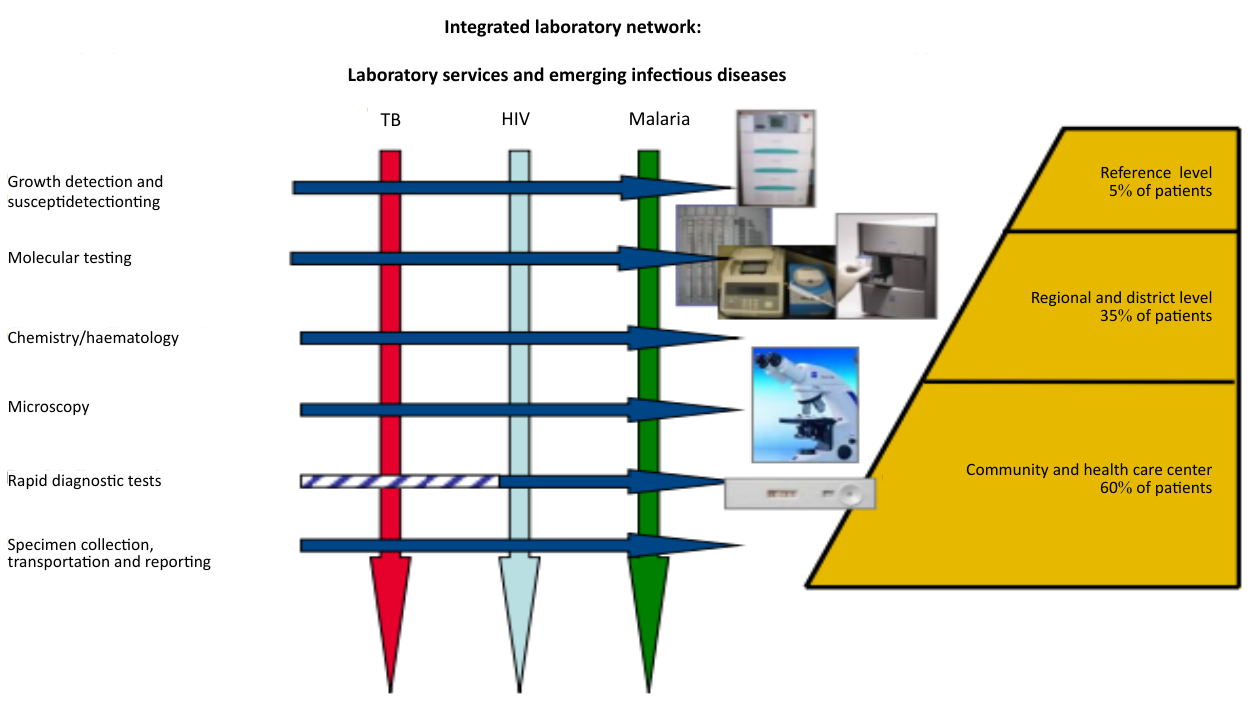
FIGURE 1: The framework of integrated laboratory services that addresses levels of a tiered laboratory network in developing